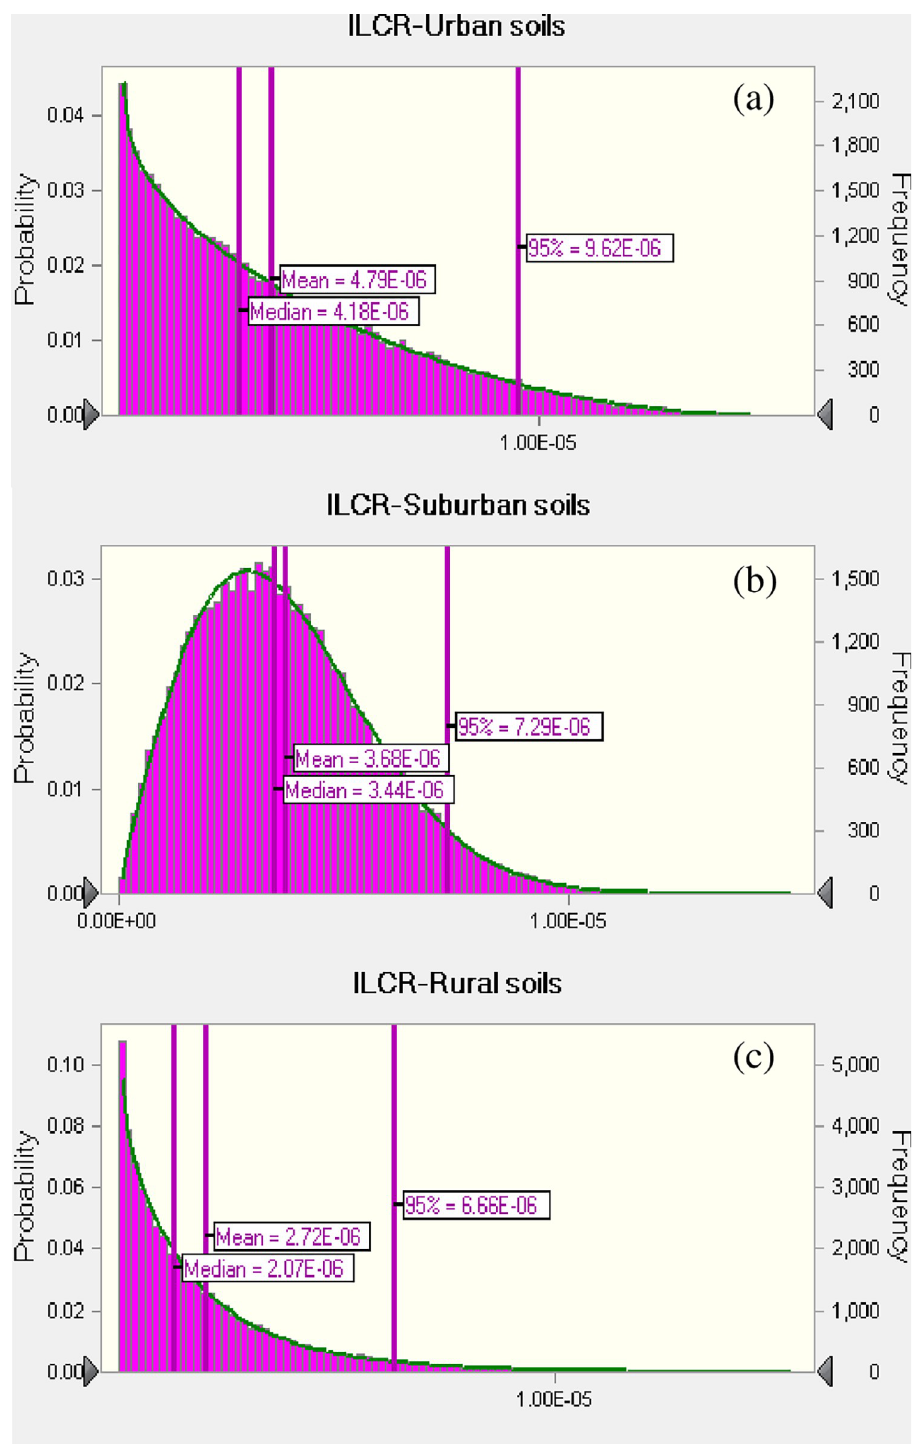
Fig 4. Predicted probability density functions of incremental lifetime cancer risk (ILCR) for adults exposed to the PAHs in urban soils (a), suburban soils (b) and rural soils (c).